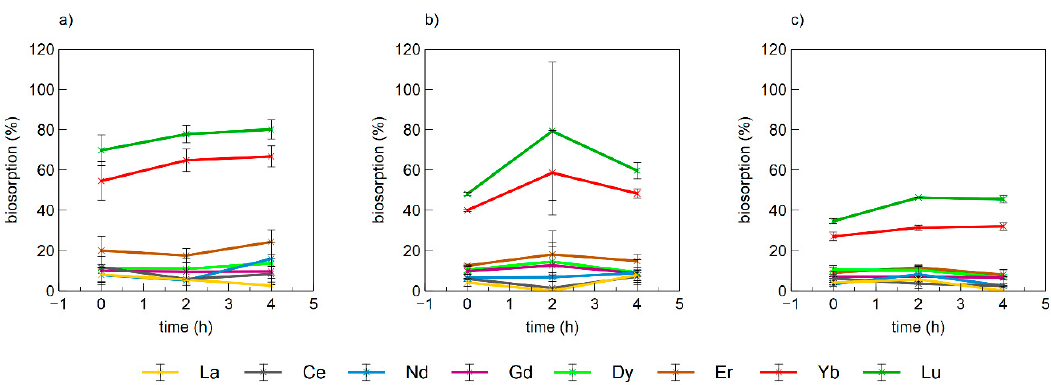
Figure 1. Biosorption of REEs by B. subtilis with increasing REE / BM ratio at pH 2.5, BM 4 g / L, ( a – c ): REE / BM ratio 3.75, 7.5 and 15, respectively; REE concentration of each element was 15, 30 and 60 µ mol / L, respectively. Error bars show standard deviation of two parallels.